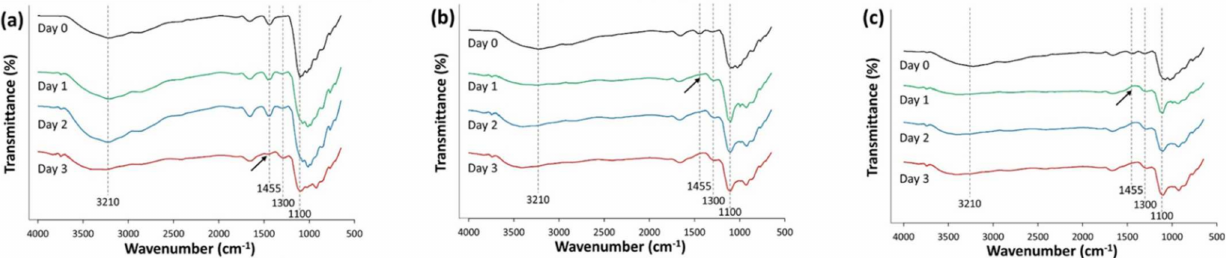
Figure 3. Time course for the FT-IR profiles of the three microbial consortia during biodegradation of the azo dye Acid Blue 113. ( a ) B-C, ( b ) Y-C, and ( c )